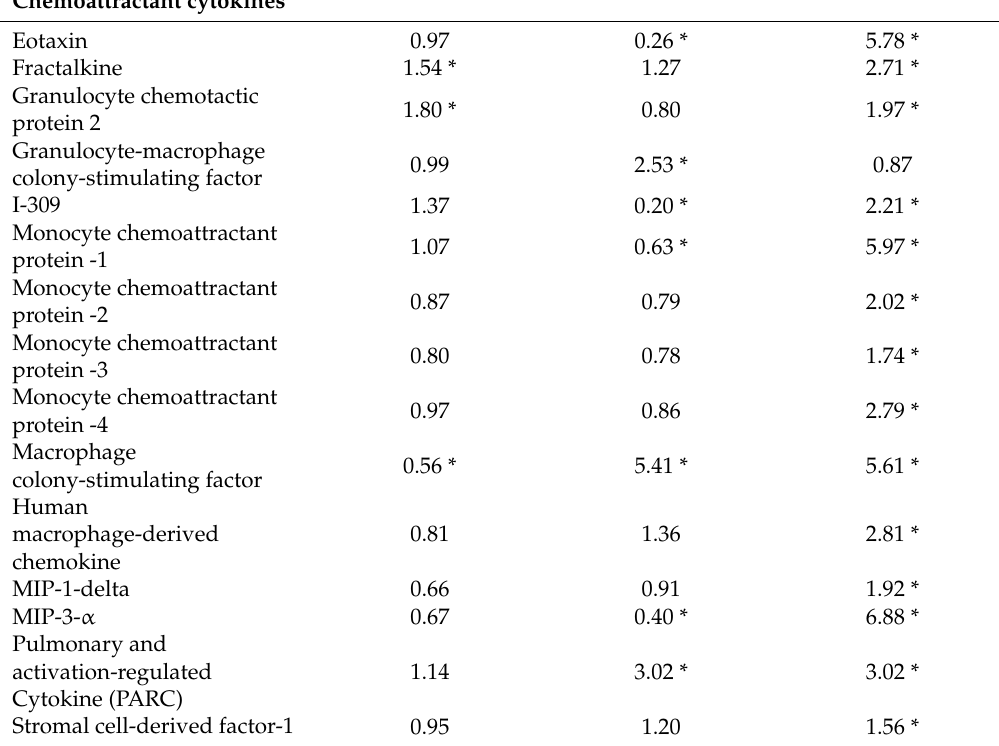
Figure 6. Biplot PCA model representing the correlation structure of the dataset in a two ‐ dimensional space of the fatty acid profile ( n = 40 fatty acids determined) obtained by gas liquid chromatography and cytokine profile ( n = 60 cytokines) obtained by protein arrays from milk samples. 4. Discussion Breastfeeding serves as a source of optimal nutrition and bioactive factors for infant development, especially when maternal nutrition is optimal. Human milk fat content and omega ‐ 3 FA (DHA) are crucial for infant neurodevelopment [8,11–17]. Omega ‐ 3 FAs have been proven to